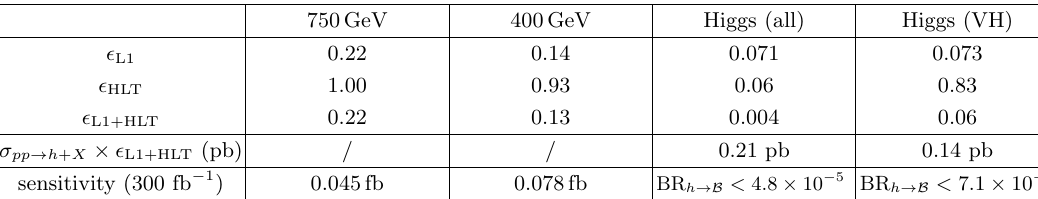
Table 5. Trigger e(cid:14)ciencies and estimated sensitivity for all benchmarks, assuming 10 (cid:0) 3 level background rejection at the HLT. The (cid:12)rst three columns contain the e(cid:14)ciencies for the belt of (cid:12)re trigger. For the Higgs benchmark the GF, VBF and VH production modes are summed together. The last column presents the traditional single muon trigger path for VH production, as described in section